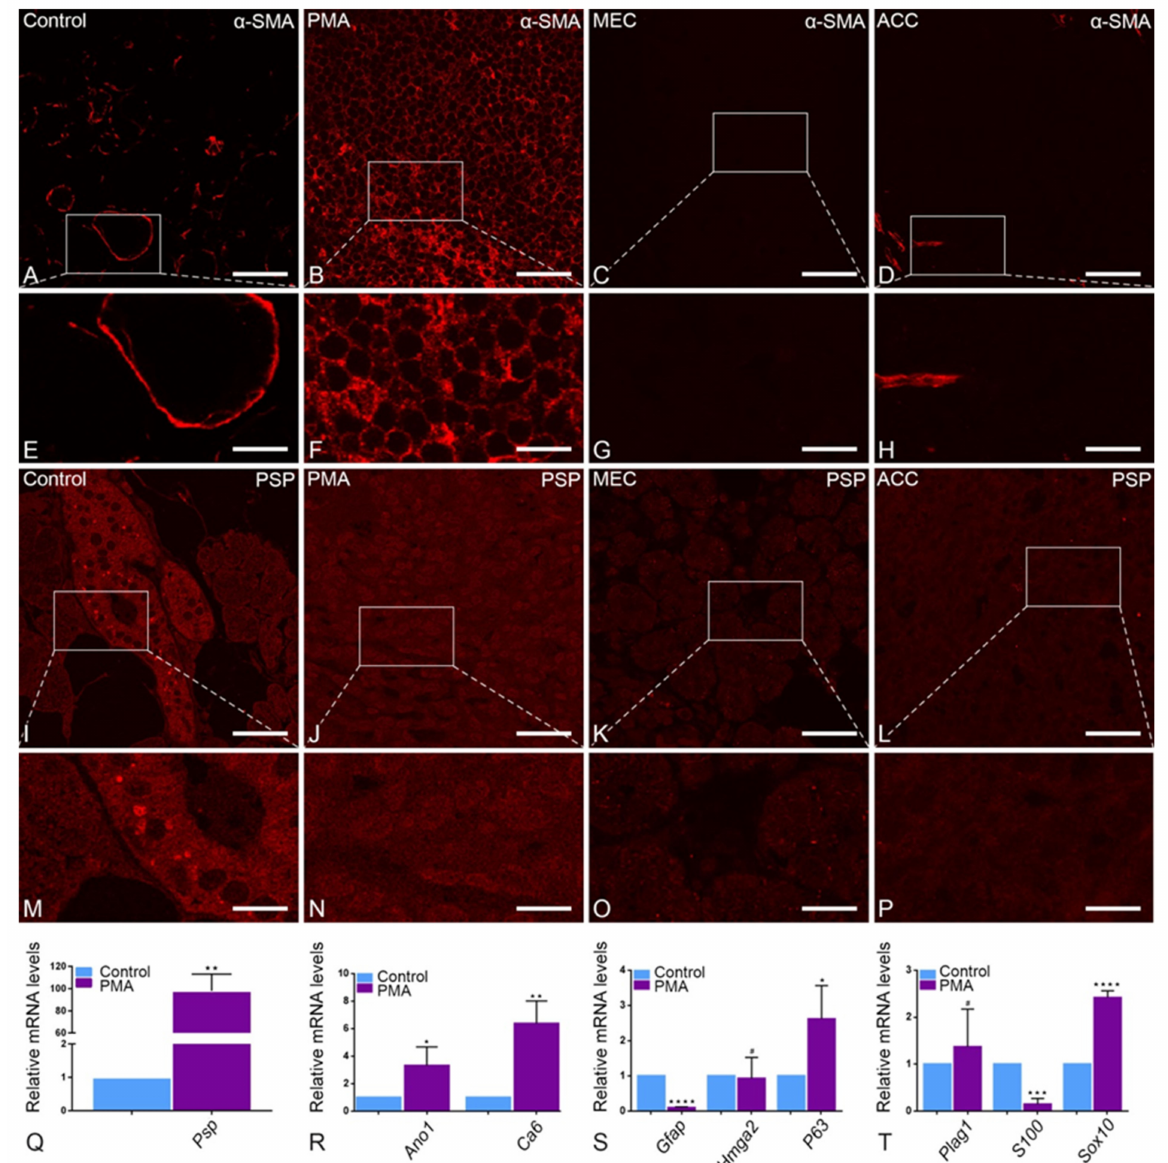
Figure 2. Comparison of control, PMA, MEC and ACC parotid gland tissue in α SMA and PSP staining: Control parotid gland in α SMA staining ( A ) reacts positive as well as PMA in α SMA staining ( B ), and their respective magnifications-control ( E ) and PMA ( F ). In α SMA staining of MEC ( C ) and its magnification ( G ), just as ACC ( D ) and its magnification ( H ), shows significantly less reaction. Control parotid gland ( I ) shows a high abundance of PSP, especially in the magnification of its striated ducts ( M ). PMA ( J ) and its magnification ( N ) react in a similar pattern to the control group, but with a slightly higher intensity. PSP-stained MEC ( K ), its magnification ( O ) and PSP-stained ACC ( L ), and its magnification ( P ), show weaker responses compared to the control group. mRNA expression of Psp in control parotid gland and PMA as determined by real-time PCR analysis ( Q ) quantify the results of immunofluorescence (** p = 0.0030). The mRNA expression of Ano1 (* p = 0.0420) and Ca6 (** p = 0.0049) ( R ), P63 (* p = 0.0426) ( S ), as well as Plag1 and Sox10 (**** p < 0.0001) ( T ) in the control parotid gland and PMA as determined by real-time PCR analysis show a higher abundance in PMA. In comparison, the mRNA levels of Gfap (**** p < 0.0001), Hmga2 ( S ) and S100 (*** p = 0.0003) ( T ) are expressed lower in PMA. Bars represent 50 µ m: ( A – D , I – L ); 18 µ m: ( E – H , M – P ). (Explanation of the notations: The number of asterisks signifies the degree of significance of the p -value, while # means not